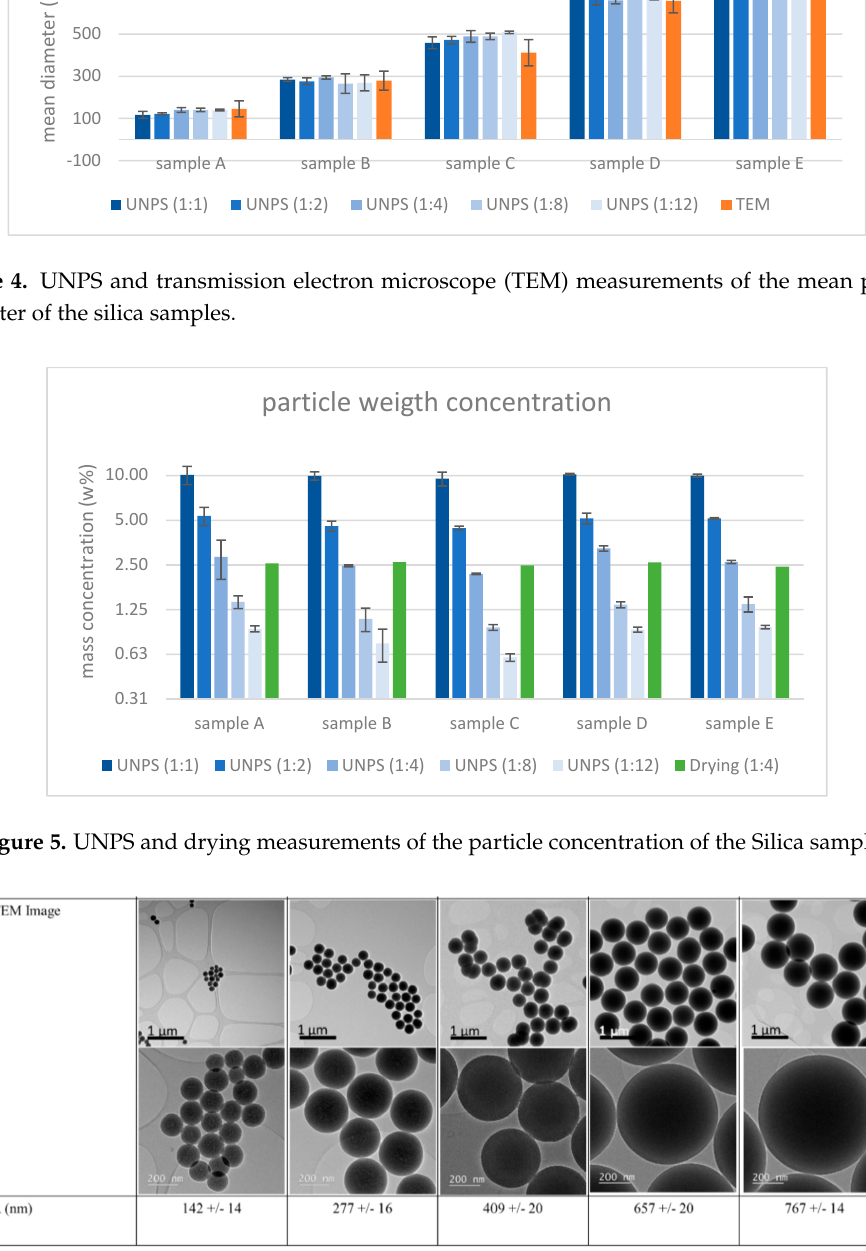
Figure 6. TEM images of the silica samples. From left to right: sample A, B, C, D, E.